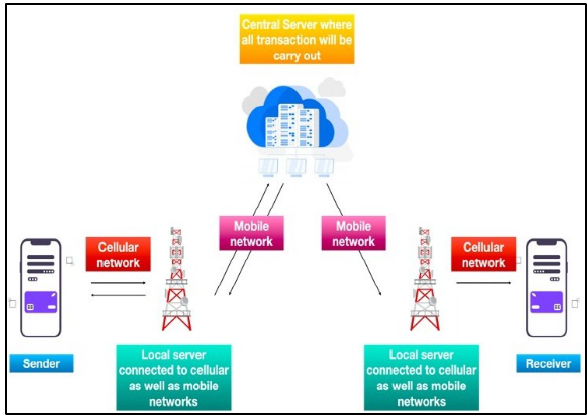
Fig. 1. Proposed System Architecture